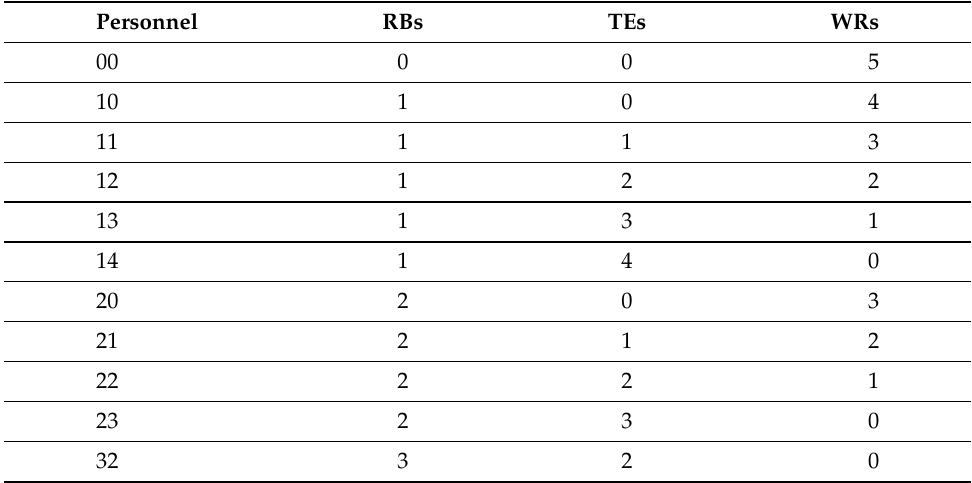
Table 2. The personnel identification is determined by the number of running backs (RB), tight ends (TE), and wide receivers (WR) (this table is not exhaustive).